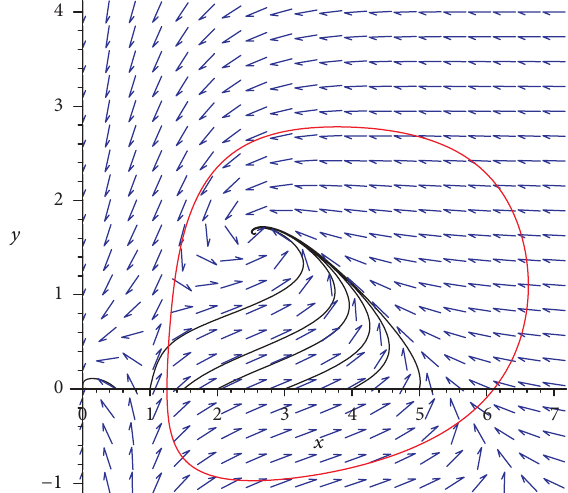
Figure 4: The DOA when 𝑎 = 40 for the model given by (20).